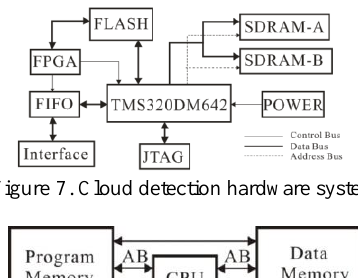
Figure 8. Improved Harvard structure